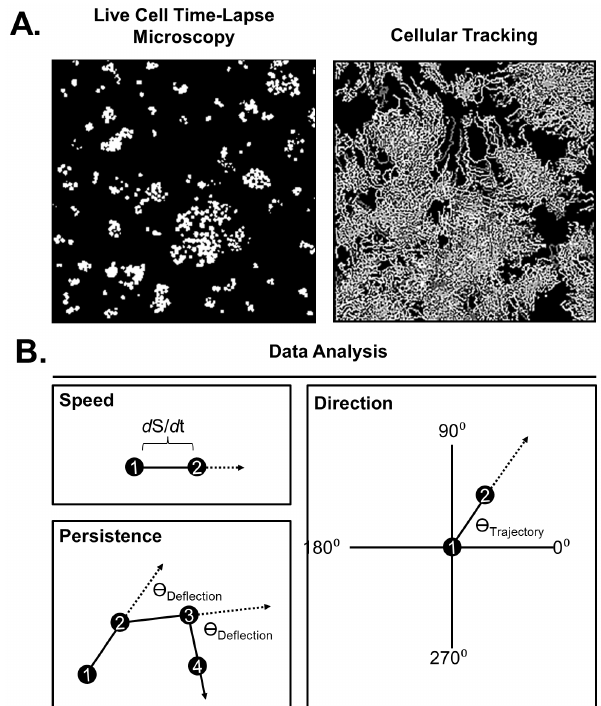
Figure 2. Angular measurements of cellular migration can reveal cellular behavior. A ) The Pathfinder program converts time- lapse microscopy videos of fluorescent HaCaT cells (left) to cellular tracks (right). B ) The Pathfinder program uses the positional information of cellular tracks to calculate speed, where d S represents change in position and d t represents change in time (top), migration persistence through the absolute angle of deflection (bottom), and the migration direction relative to a well-defined axis orientation in the field of view (right).